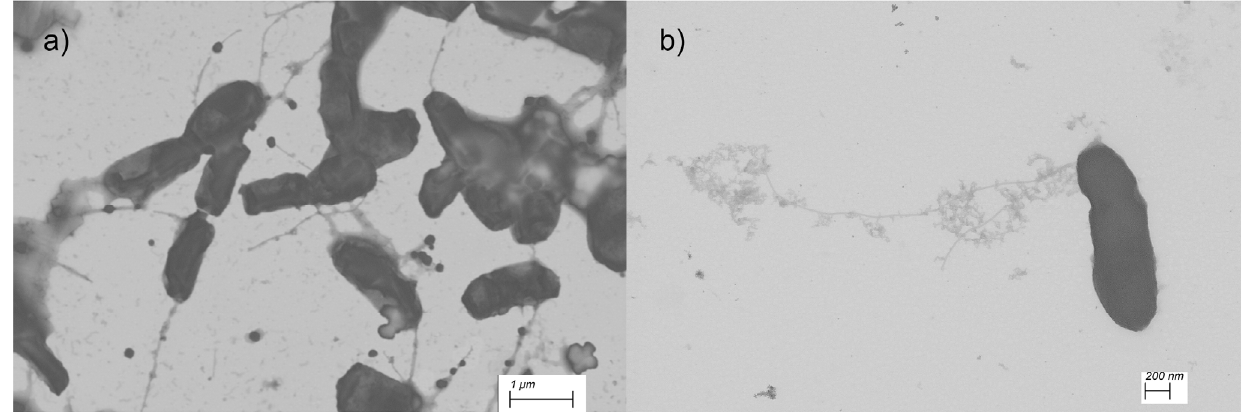
Figure 3. Scanning transmission electron microscope images of negatively stained cells of strain KMM 9957 T grown on MA 2216 at 25 °C for 24 h. Bar, 1.0 μ m ( a ) and 0.2 μ m ( b